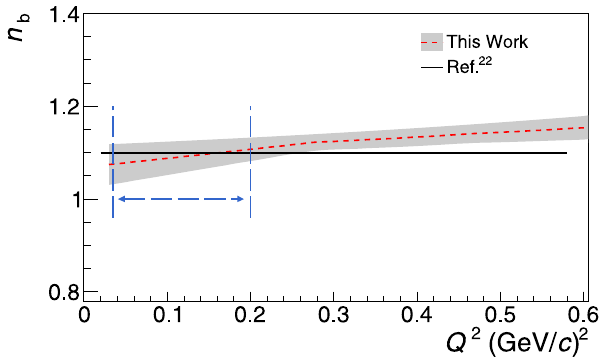
Fig. 2 The experimentally determined symmetry breaking contributions. The breaking corrections n b (dashed line) and the associated uncertainty δ n σ or 68% con fi dence level. The solid line b (shaded band) at the 1 indicates the n b as theoretically determined in 22 . The horizontal double- arrow marks the Q 2 -range where the corrections have been employed for the measurement of G n in this work. E